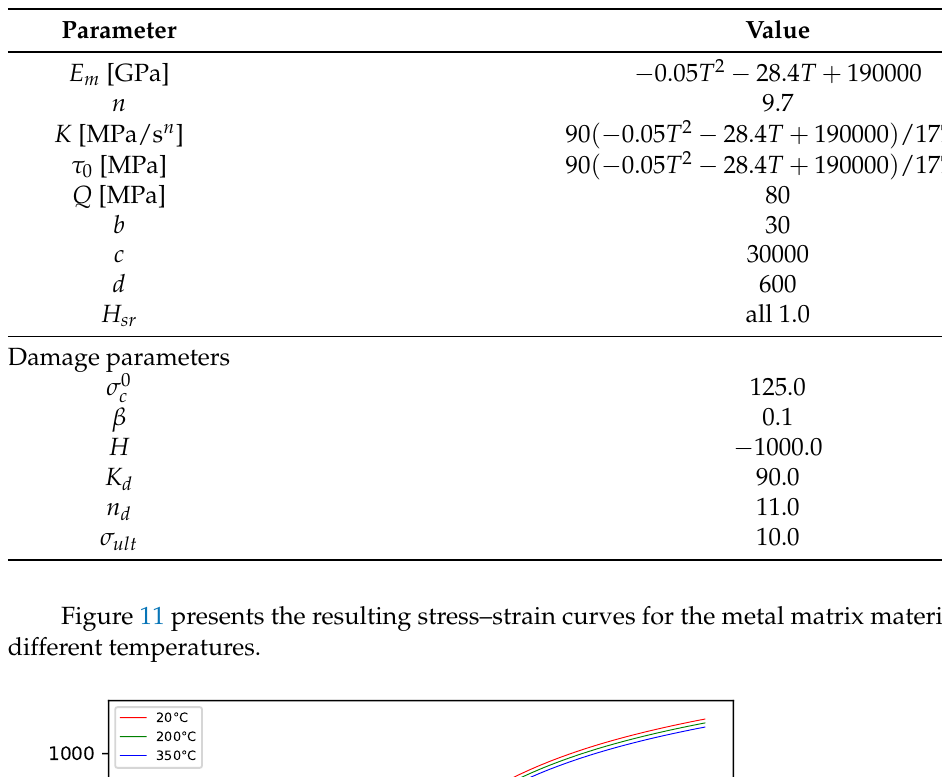
Table 3. Material parameters of metal matrix.